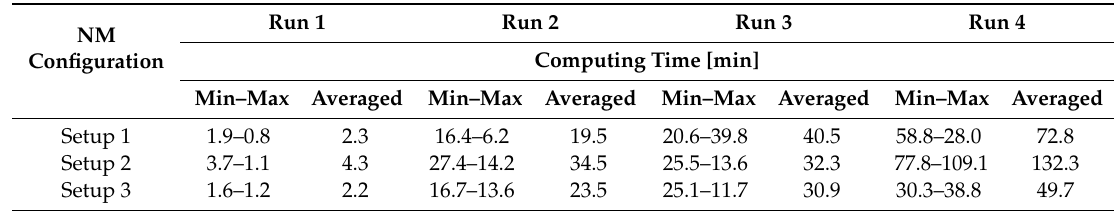
Table 8. The computing time in each run and for each NM setup.